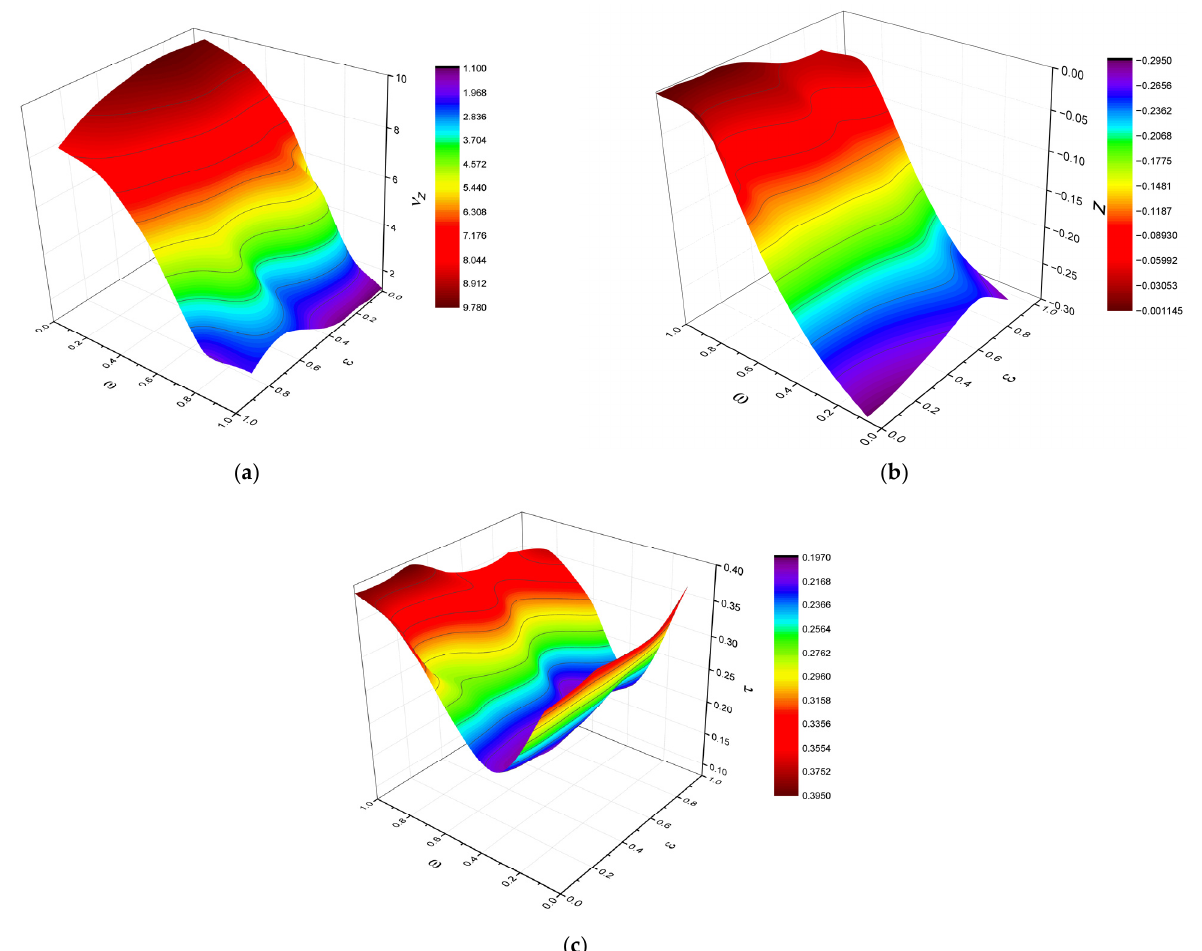
Figure 8. Approximate function surfaces: ( a ) Average value of axial speeds; ( b ) Inlet loss factor; (c) Factors of average angular speed.